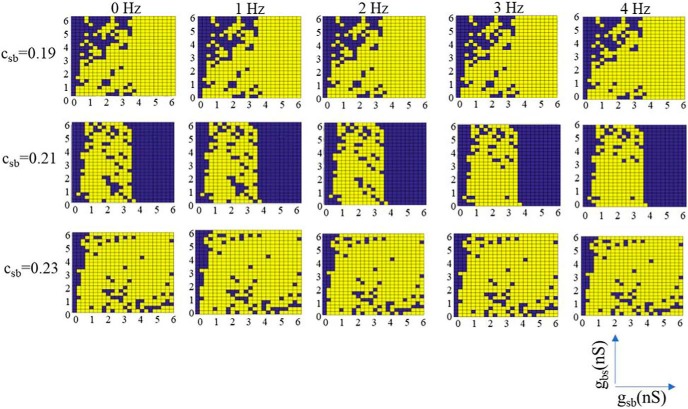
Selected and rejected parameter sets using different lower frequency bounds. The different frequency bounds used are shown at the top of each column and only three different csb values are shown. Note that we use 3 Hz as the frequency bound in Figure 4.